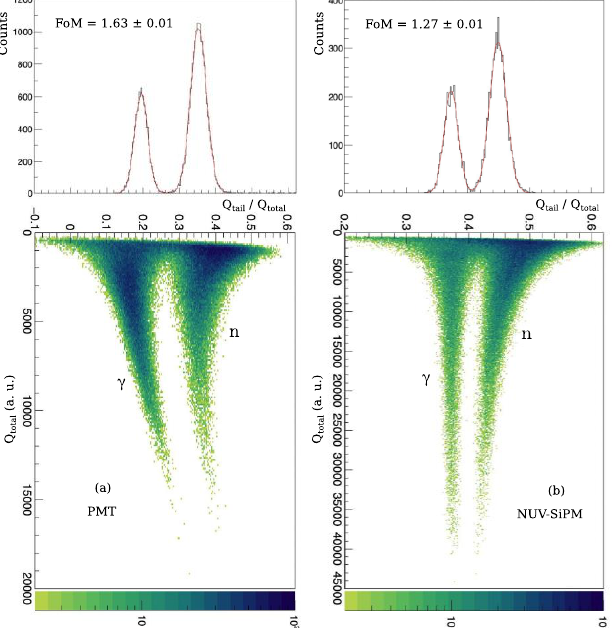
Fig. 6. 2D plots, PSP versus Q total , corresponding to the measurements using the Am-Be source with the EJ-299 (20 mm dia. x 20 mm thick.) coupled to the PMT (a) and to the NUV-SiPM array (b). PSP distributions and FoM values (at ~1 MeVee) are reported on top.